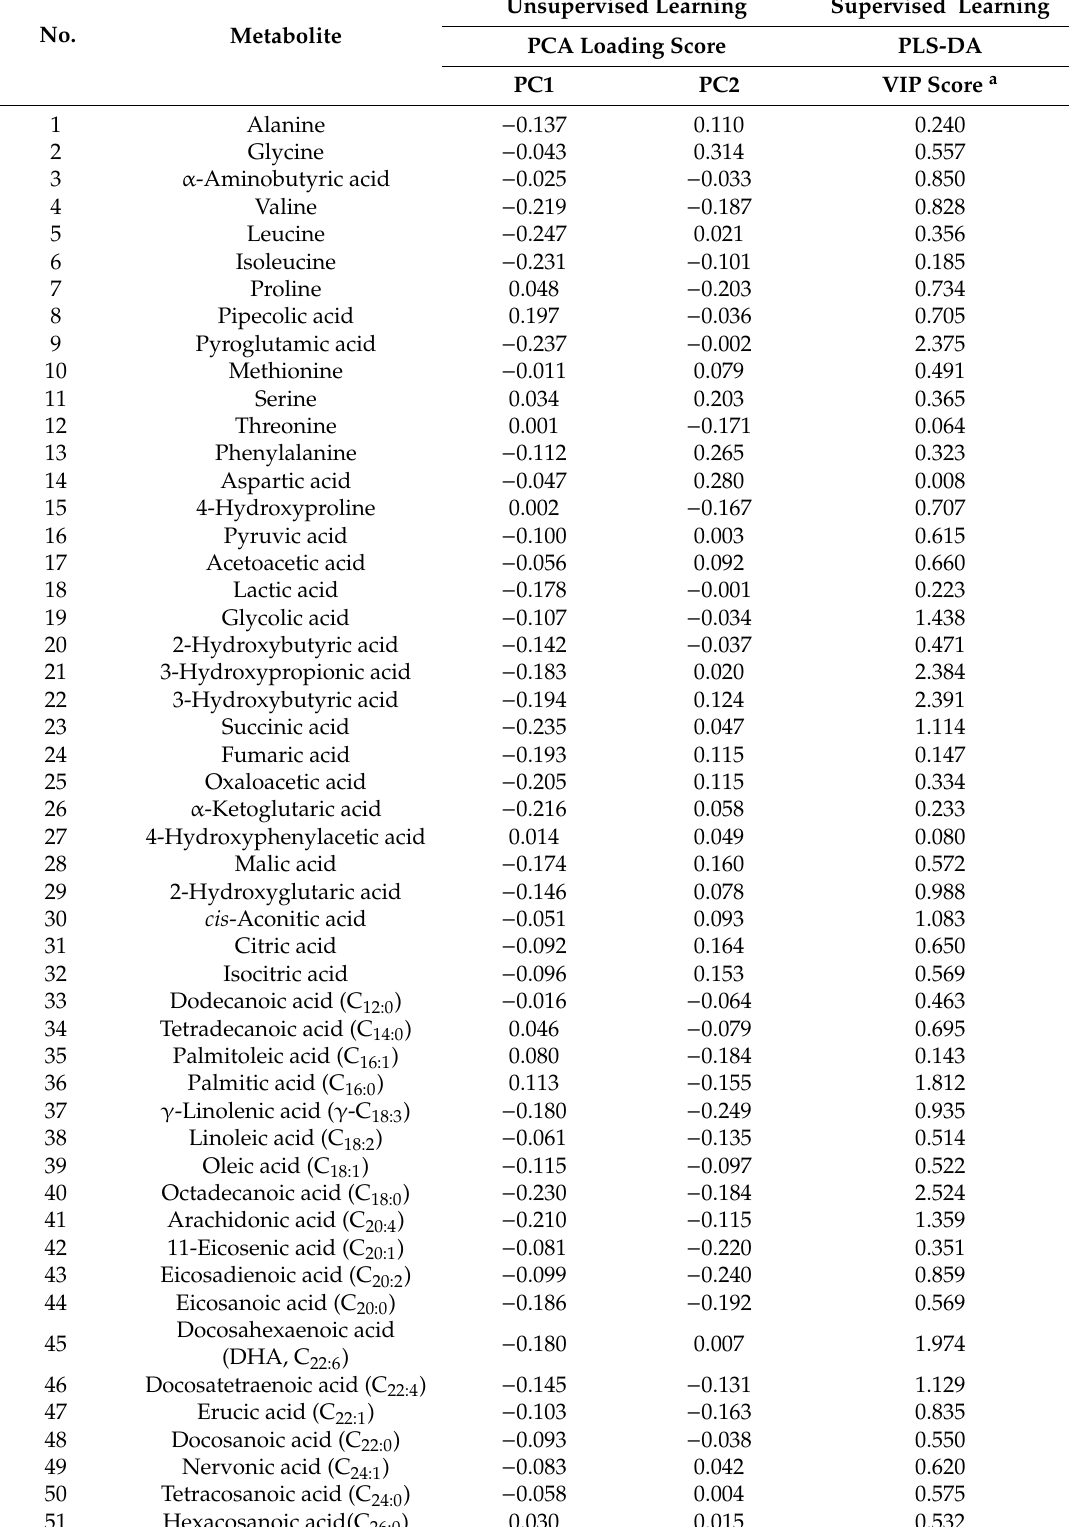
Table 2. The PCA loading score and variable importance point (VIP) score of